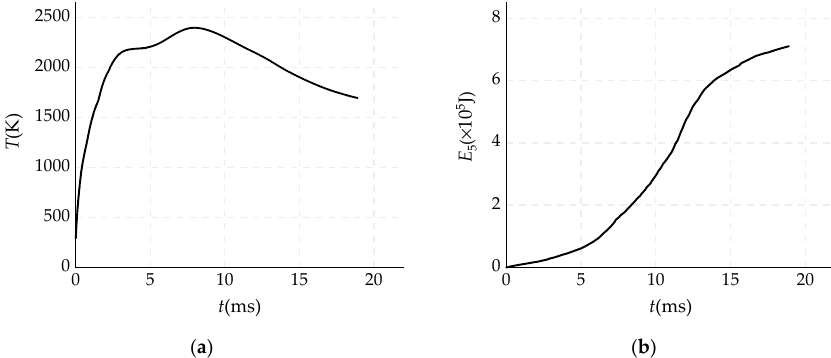
Figure 13. ( a ) Average temperature of propellant gas, ( b ) thermal energy of the gun barrel. Energies 2020 , 13 x FOR PEER REVIEW